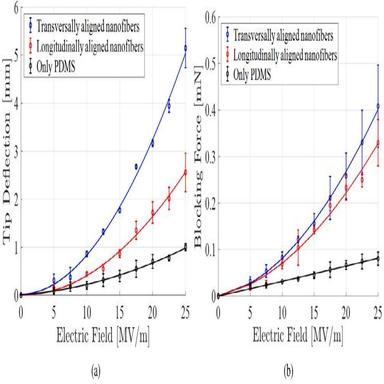
Electromechanical characterization (mean on at least three specimens and standard deviation) of the soft actuators with transversally aligned nanofibers (blue) longitudinally aligned nanofibers (red) and isotropic pure PDMS (black). (a) Tip deflection. (b) Blocking force.